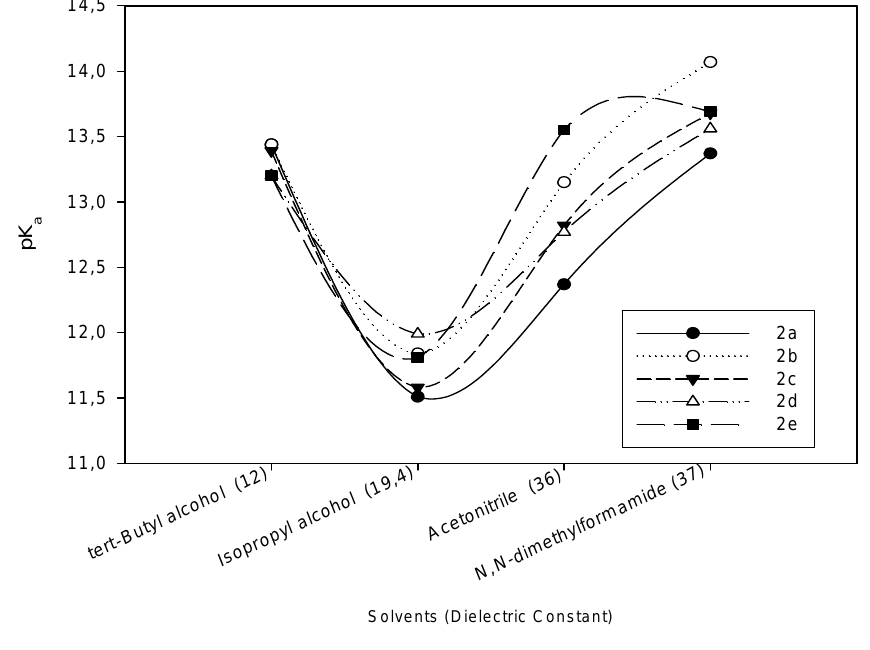
values with the dielectric constant of the solvent. a